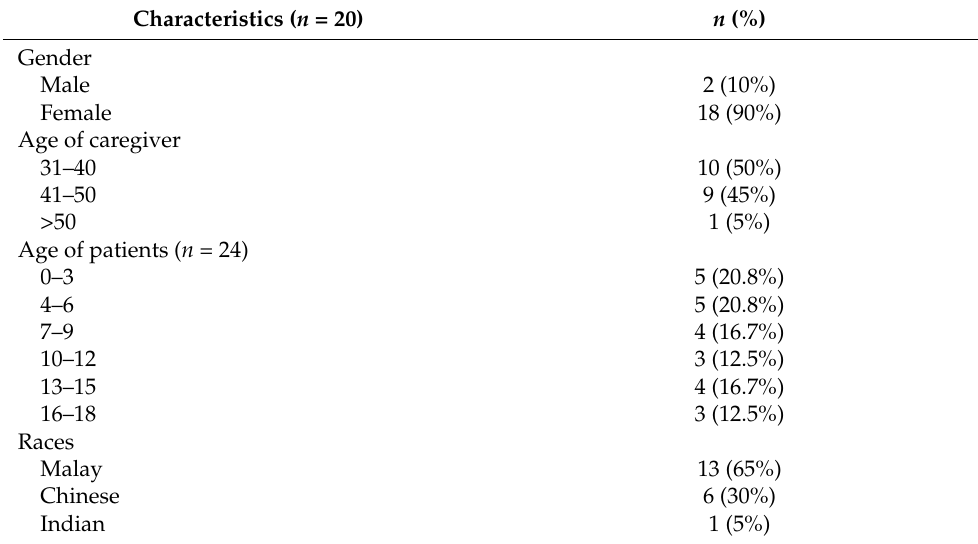
Table 2. Sociodemographic characteristics of the caregivers of AAMD